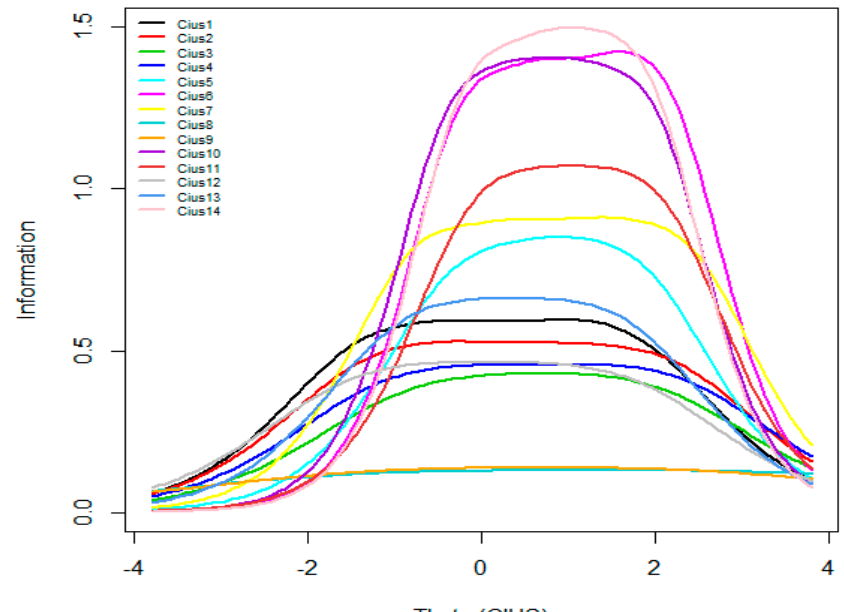
Figure 2. Item information curves.